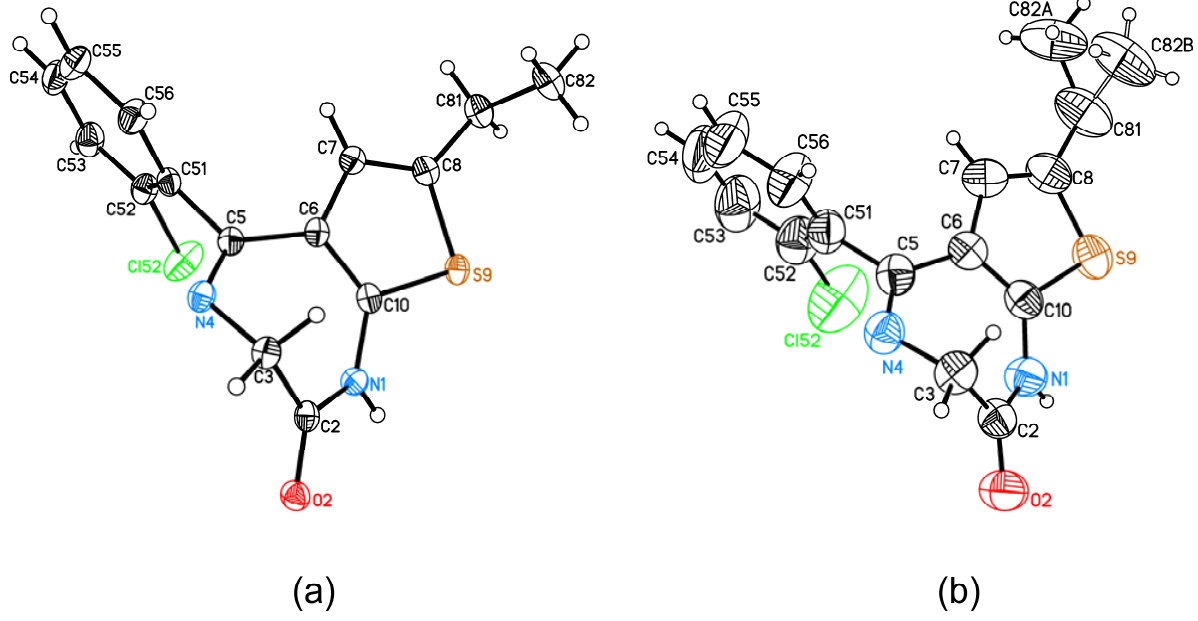
Figure 2. Ellipsoid representation of molecule 1 at ( a ) 125 K and ( b ) 300 K, together with the atom labeling scheme [11]. The ellipsoids are drawn at 50% probability level, hydrogen atoms are depicted as spheres with arbitrary radii. In Figure 2b the C81 hydrogen atoms are omitted for clarity.